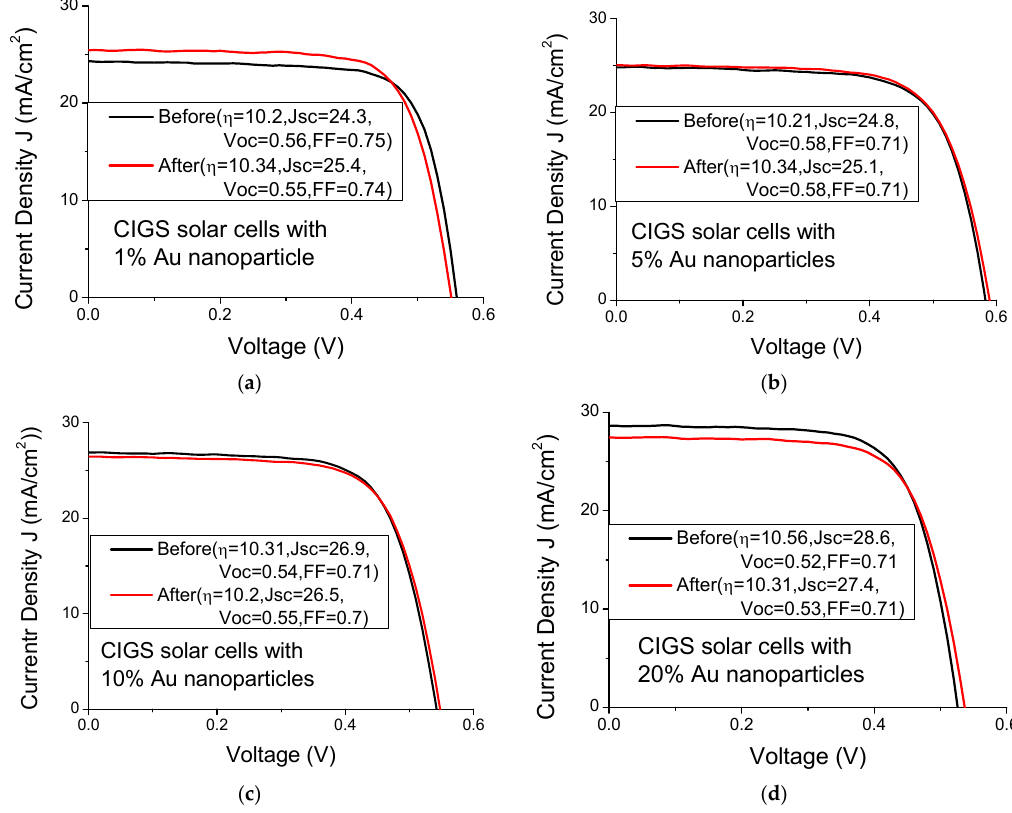
Figure 6. Current ‐ voltage curves of CIGS solar cells with various Au nanoparticle concentrations of ( a ) 1%; ( b ) 5%; ( c ) 10% and ( d ) 20%. Table 2. The mean photocurrent and efficiency enhancement of three CIGS solar cells upon the incorporation of various concentrations of Au and Ag nanoparticles.